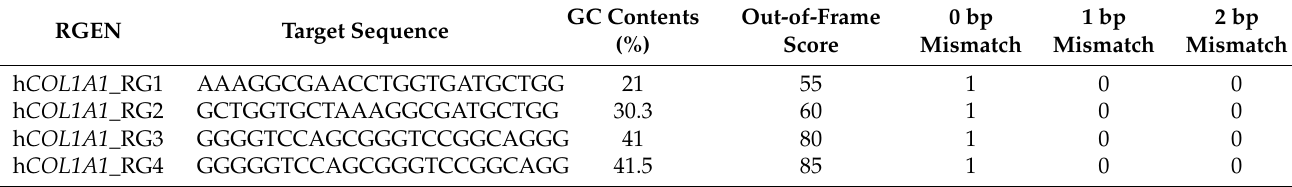
Table 1. Off-target